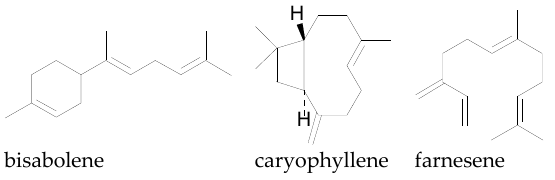
Figure 5 . Chemical structures of some monoterpenes in plants, including cotton.